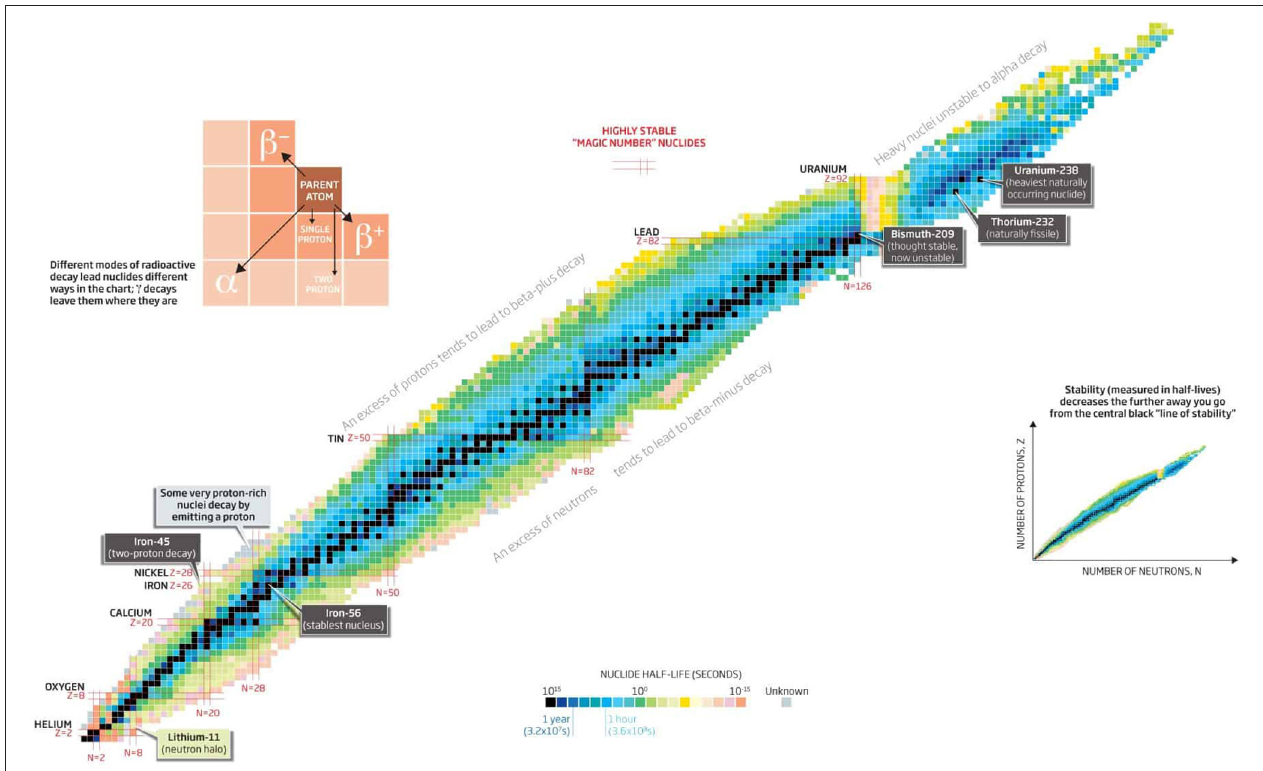
FIGURE 1 | The nuclear chart, a plot of the known isotopes as a function of their number of protons and neutrons. Each isotope is the tiny square on the chart. Taken from